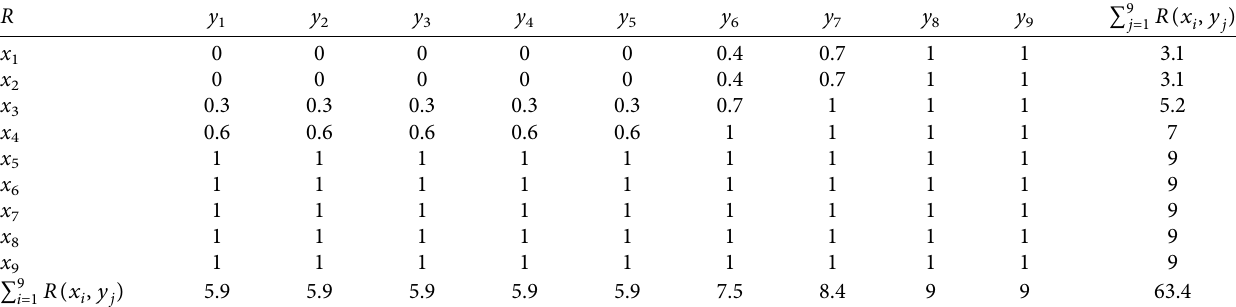
i , y j ) in Example 1.